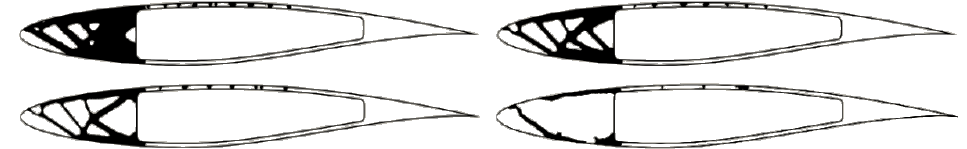
Figure 11. Material layout distribution for the general case study, considering 50%, 35%, 25% and 10% mass constraint reduction targets.